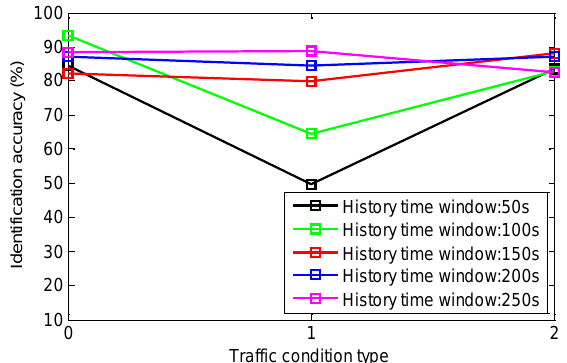
Figure 19. Comparisons based on length range of slide time window that varies from 50 s to 250 s.